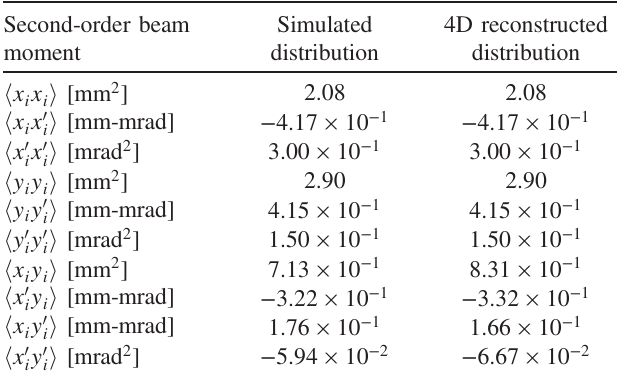
TABLE IV. Second-order moments of the beam ’ s 4D transverse phase space distribution for (i) the simulated distribution and (ii) four-scan 4D MENT